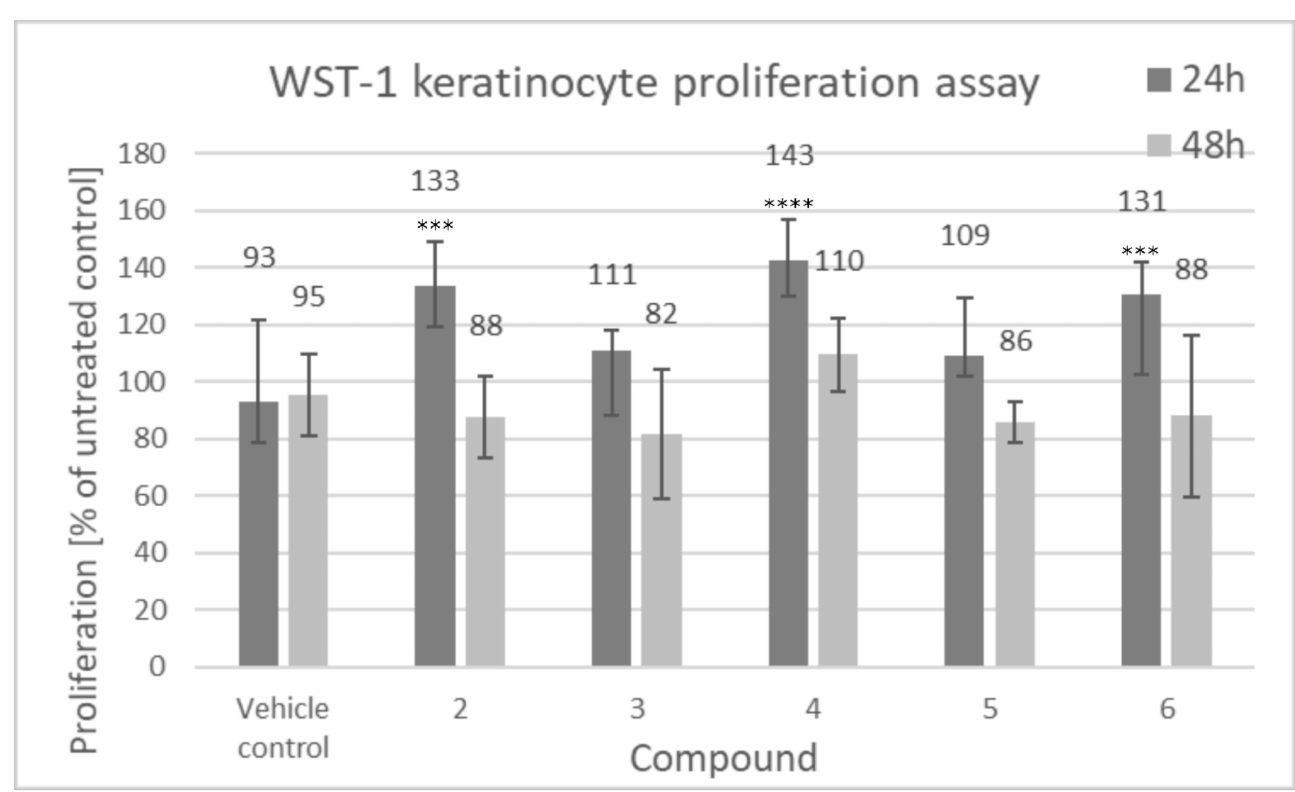
Figure 5. Proliferation of human keratinocytes (WST-1 assay), compounds tested at 100 µ M (2: lupeol acetate, 3: lupeol propionate, 4: lupeol isonicotinate, 5: lupeol succinate, 6: lupeol acetylsalicylate). Cells were seeded at the density of 5 × 10 3 cells per well of a 48-well plate, 24 h prior to addition of tested compounds. The incubation was carried out for 24 h and 48 h. Data presented as mean values ± SD. Statistical analysis by multiple comparison one-way ANOVA; *** p ≤ 0.001; **** p ≤ 0.0001 compared with the vehicle